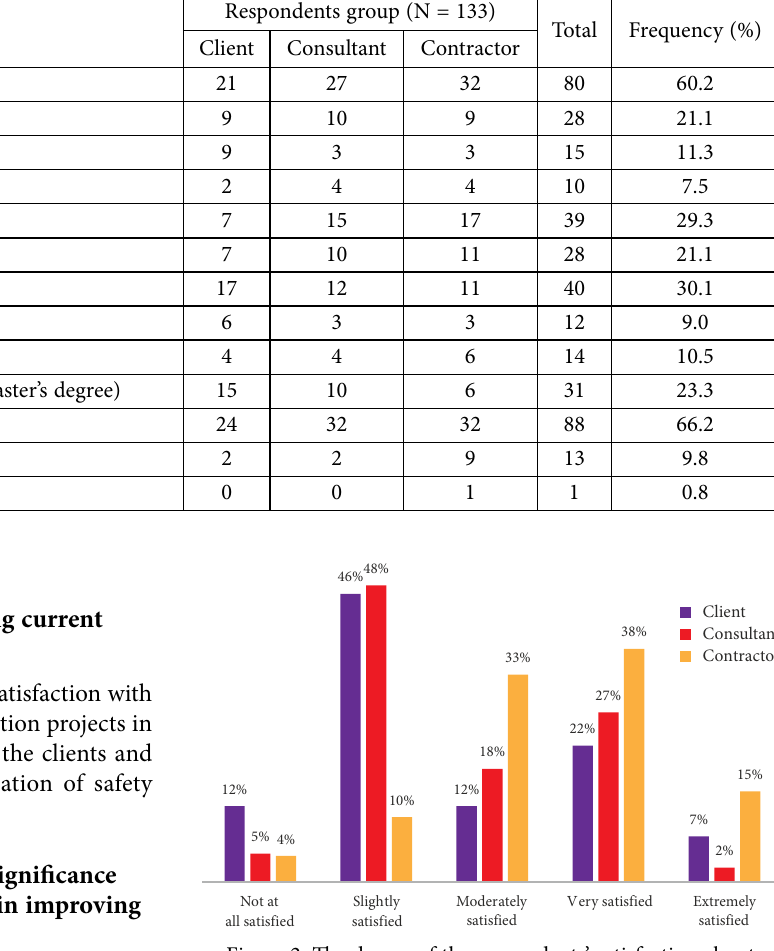
Figure 2. The degree of the respondents’ satisfaction about